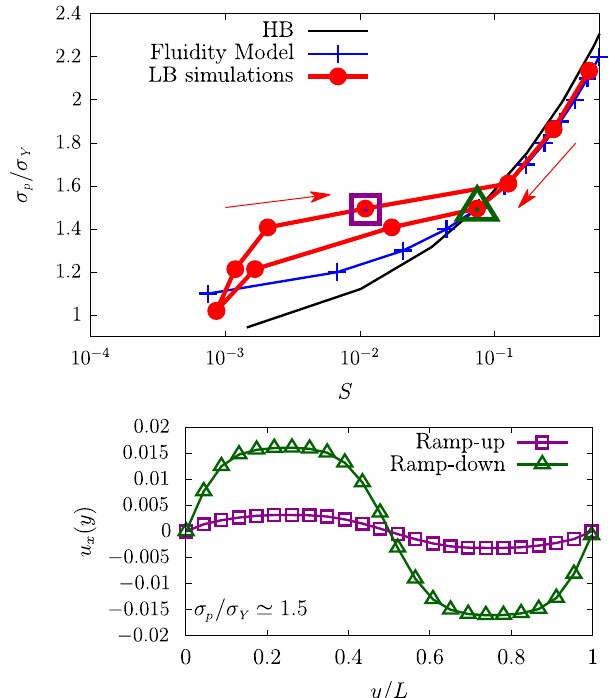
clearly visible: ramp-up (upper line with right-pointing arrow) and ramp-down simulations (lower line with left-pointing arrow). Rheological data extracted from simulations are compared to the results obtained from the fluidity model [7,8,27] (blue crosses) and the HB [33] fit in a Couette geometry (black continuous line). flowing regime. The purple empty square and the green empty triangle signal the position on the rheological curve of the corresponding profiles shown in the bottom panel. Bottom panel: Velocity profiles for the Kolmogorov flow at fixed peak-stress = σ ≃ 1 . 5 obtained from two different protocols: ramping value σ p Y up from lower peak-stress values (purple empty squares) and ramping down from larger peak-stress values (green empty triangles). This is clear evidence of the existence of two stable rheological branches, signaling that the static yielding threshold is above the dynamic one [28].